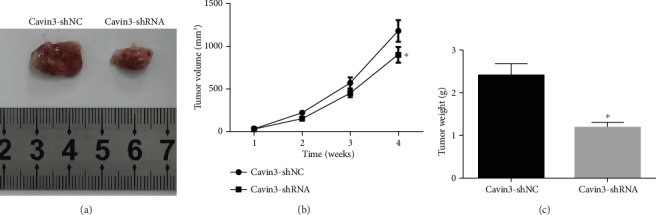
Tumor formation of lung cancer in nude mice in vivo. (a) Pictures of transplanted tumors and corresponding (b) growth curves of tumor volume as well as (c) histogram of tumor weight (∗ means p < 0.05, N = 2).